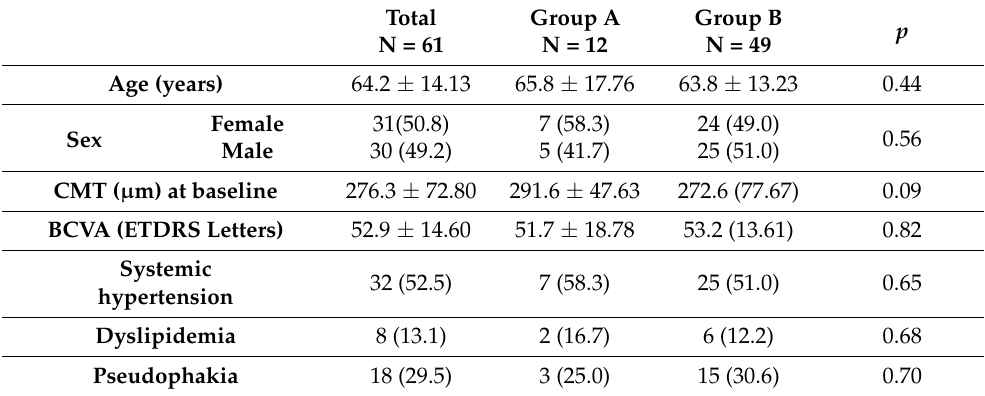
Table 1. Baseline demographic and clinical ocular and systemic characteristics of study patients.